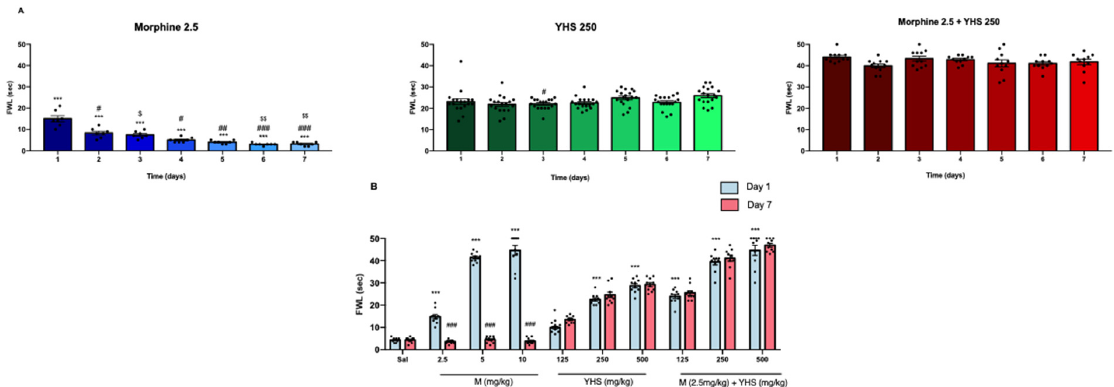
Figure 2. YHS inhibits morphine tolerance. A: FWL at 30 min after morphine 2.5 mg/kg (M2.5), YHS (250 mg/kg), and morphine +YHS (M2.5+YHS) (i.p. administration) over a period of 7 days (n = 7–11) to display tolerance. The black dots correlate to the number of animals used in each experiment. The gradient color for each figure shows the time-dependent change. One-way ANOVA followed by Tukey’s test revealed significant drug tolerance over 7 days F = 33.59, p < 0.0001, D1 *** p < 0.001 compared with D2-D7, D2 ### p < 0.0001, ## p < 0.01 compared with D4-D7, D3 $$ p < 0.01, $ p < 0.05 compared with D6 and D7 in the morphine (2.5 mg/kg) group. One-way ANOVA followed by Tukey’s test revealed no significant drug tolerance over 7 days for YHS (250 mg/kg) group, D3 # p < 0.05 compared with D7. One-way ANOVA followed by Tukey’s test revealed no significant drug tolerance over 7 days for the combination group. B: Comparison of FWL at day 1 and day 7 30 min after i.p. administration of morphine, YHS, and morphine + YHS (n = 10). Two-way ANOVA revealed significant tolerance amongst all morphine doses (2.5, 5, 10 mg/kg) F(9, 180) = 291.3 p < 0.0001, followed by Tukey’s multiple comparison test, ### p < 0.001. Two-way ANOVA revealed significant analgesic effects between saline and all other groups on Day 1, F(9, 180) = 291.3 followed by Tukey’s multiple comparison test *** p < 0.001 compared with saline, p < 0.05 compared with saline. YHS prevents morphine